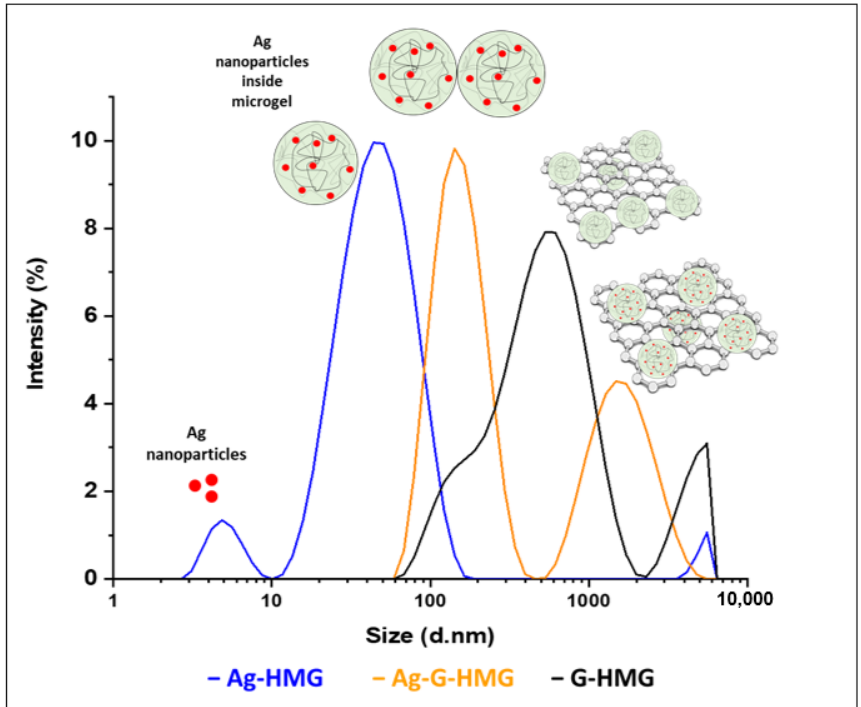
Figure 1. Zeta potential analysis of hybrid microgels.